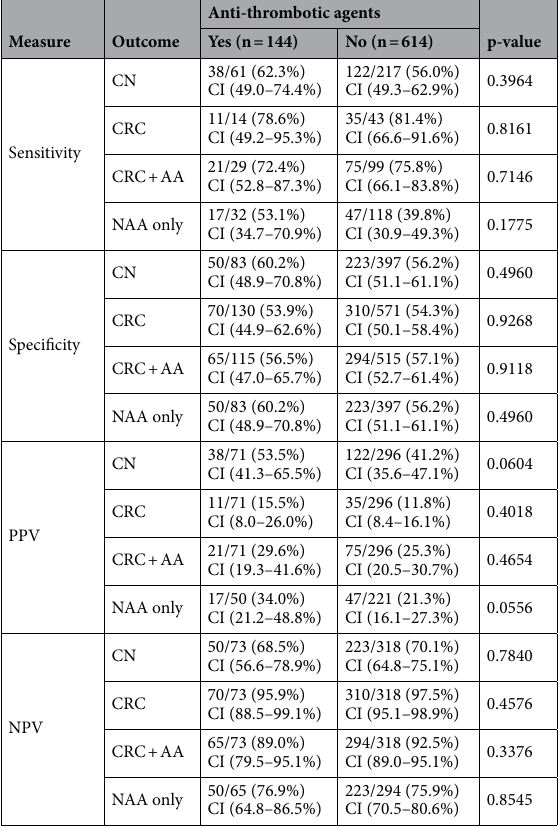
Table 2. Effects of antithrombotic drugs on the results of fecal immunochemical test in colorectal neoplasms screening. CN colorectal neoplasms, CRC colorectal cancer, AA advanced adenoma, NAA non advanced adenoma, PPV positive predictive value, NPV negative predictive value, CI confidence